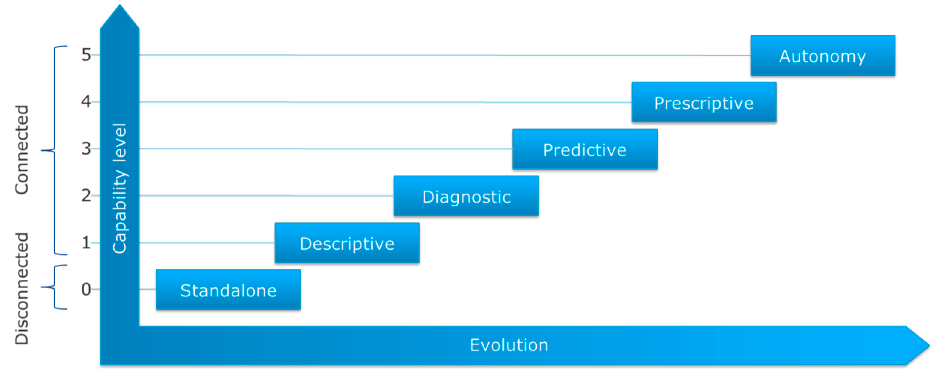
Figure 6. The capability levels of the digital twins at different stages of the evolution [62].